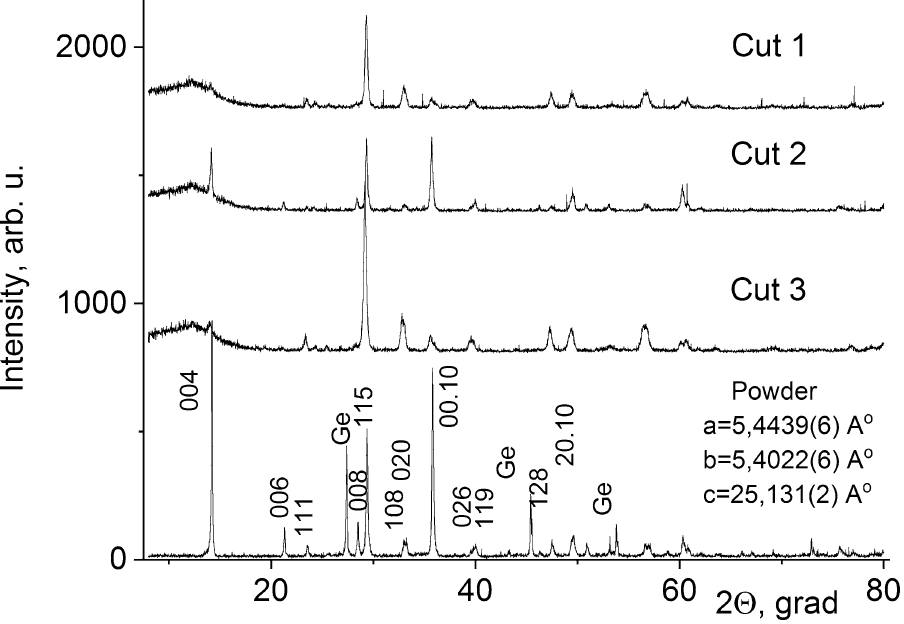
Figure 3. Diffraction patterns taken in Θ–2Θ geometry for ceramic powder and hot-pressed samples. Cuts 1, 3—made parallel to the pressing axis, cut 2—made perpendicular to the pressing axis. Ge crystal powder was used as an internal reference. Miller indices of the corresponding crystallographic planes are shown above